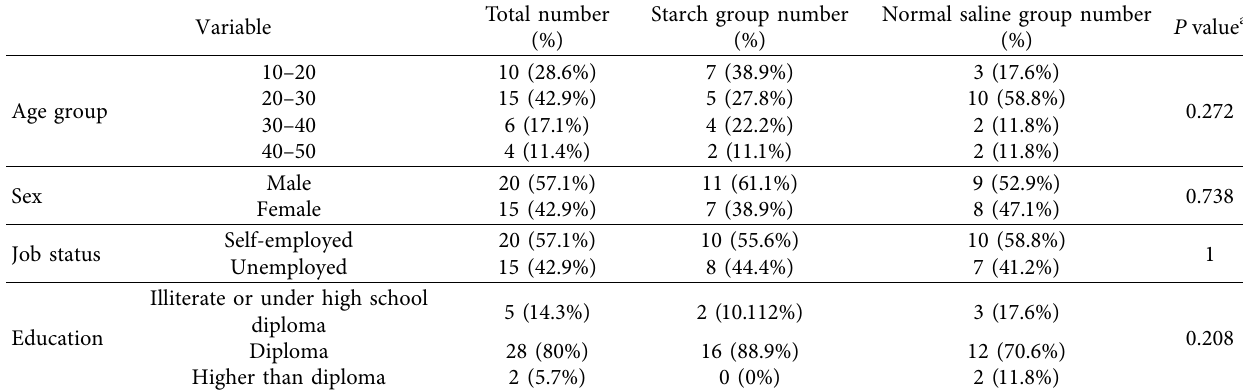
Table 1: Demographic characteristics of the participants.